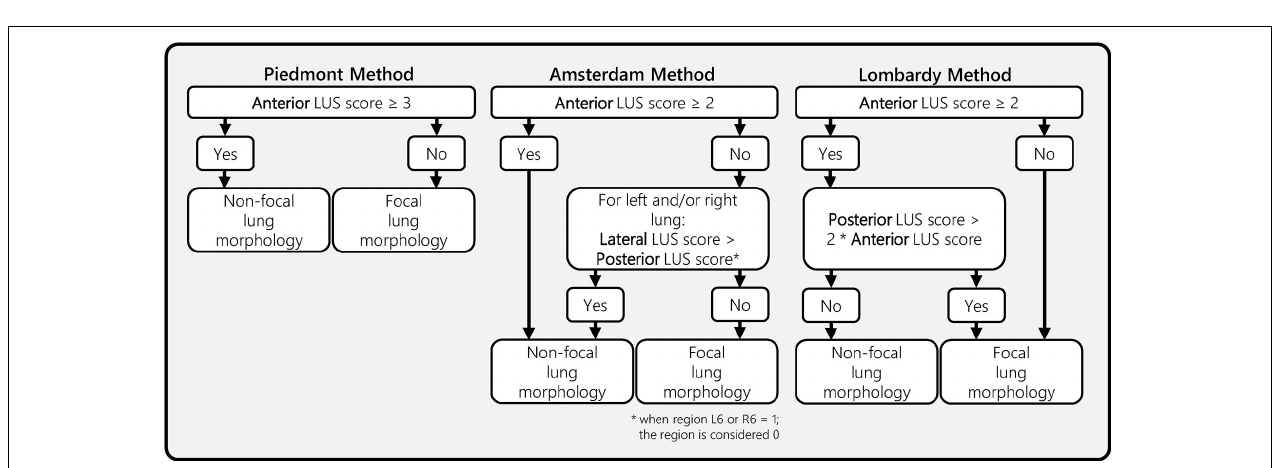
FIGURE 3 | Lung ultrasound images for all LUS patterns and scores. Each LUS image was scored with the LUS aeration score: an “A-pattern” (i.e., repeating horizontal A-lines parallel to the pleural line) was scored “0,” a “B-pattern” (i.e., ≥ 3 vertical B-lines starting from the pleural line and reaching the bottom of the screen) was scored “1” if B-lines are well-spaced and cover ≤ 50% of the pleural line, and “2” if B-lines cover ≥ 50% of the pleural line, and a “C-pattern” (i.e., consolidation) was scored “3.” The global LUS score is the sum of all 12 lung regions and reaches from 0 to 36 and the anterior, lateral, and posterior LUS score are the sum of 4 lung regions and reach from 0 to 12. LUS, lung ultrasound.